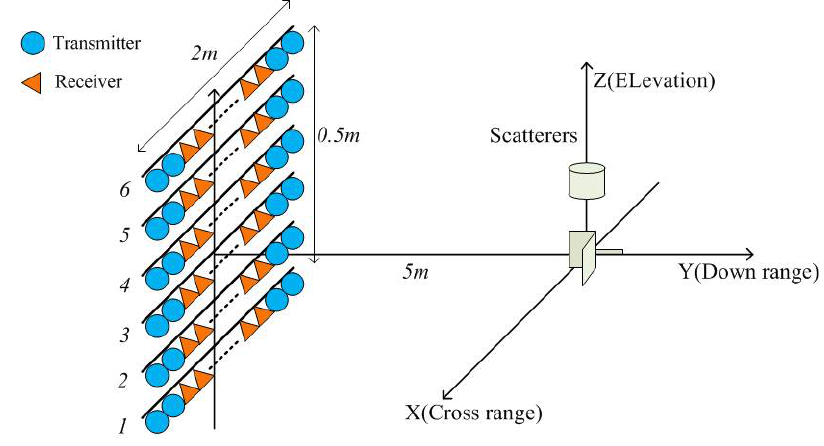
Figure 2. Simulation scene of the MIMO-SAR tomography. Sensors 2019 , 19 , x FOR PEER REVIEW